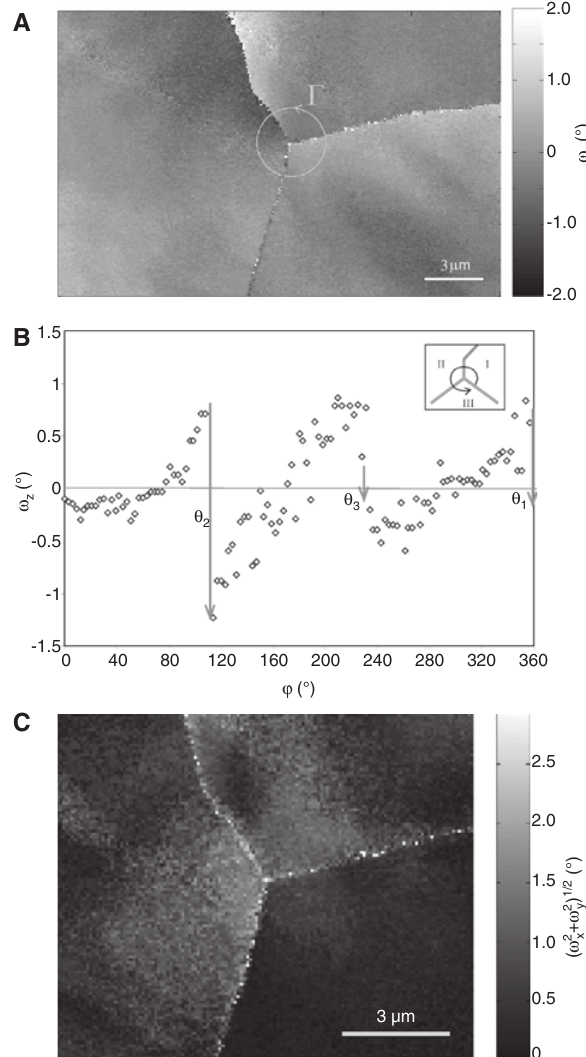
Figure 2: Mapping of lattice rotation vectors relative to average orientations of respective grains: (A) component ω section plane and (B) its azimuth dependence, (C) magnitude of non-Z (in-plane)